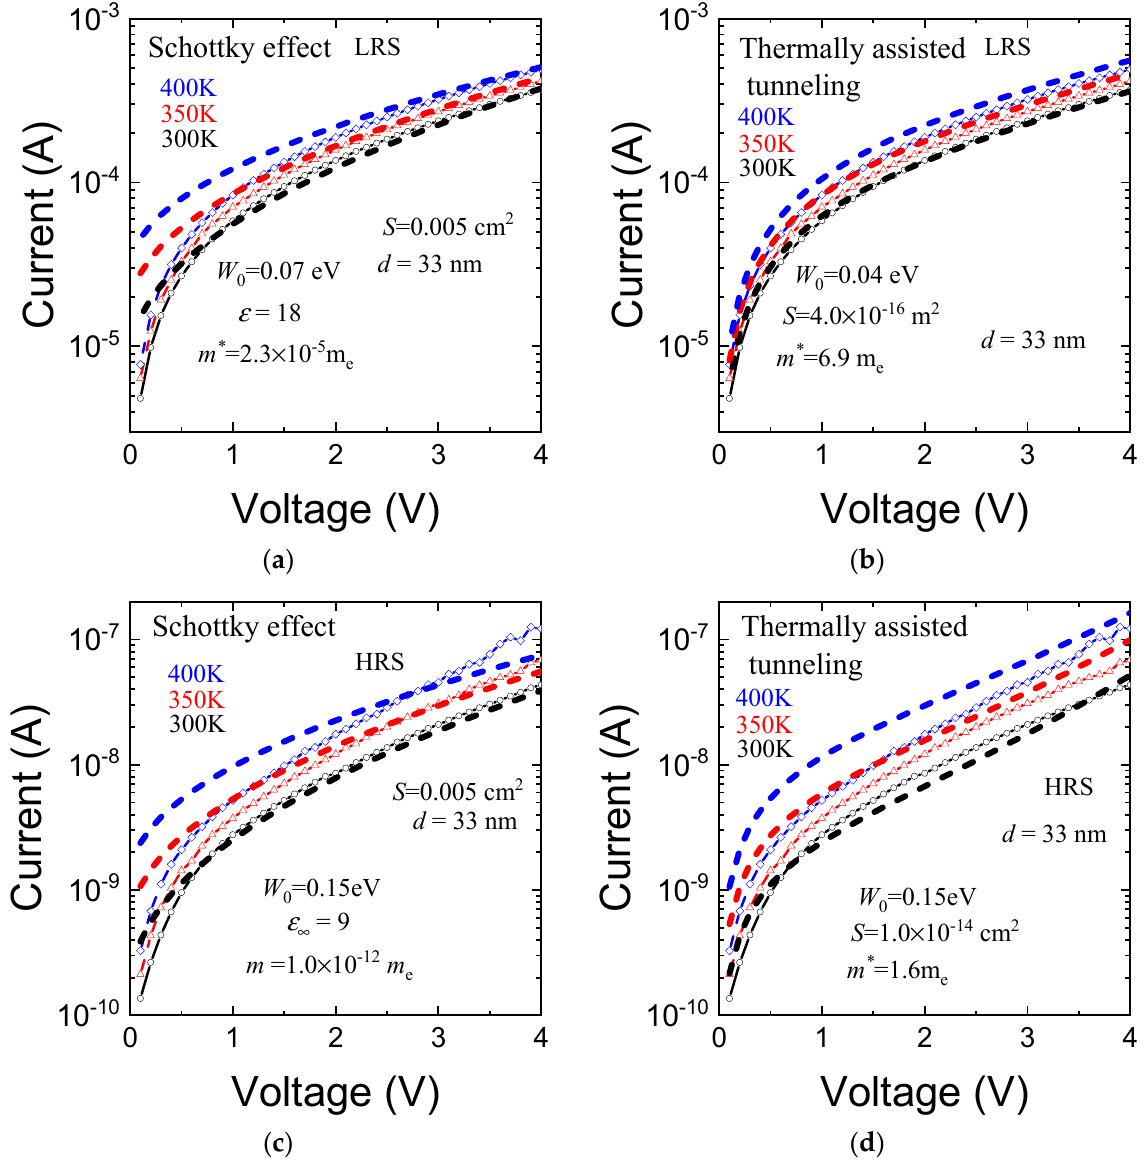
Figure 4. The IV characteristics of the PECVD SiO 0.9 N 0.6 -based memristor and simulation results by the contact-limited models: ( a ) Schottky effect in LRS; ( b ) the TAT model in LRS; ( c ) the Schottky effect in HRS; and ( d ) the TAT model in HRS.